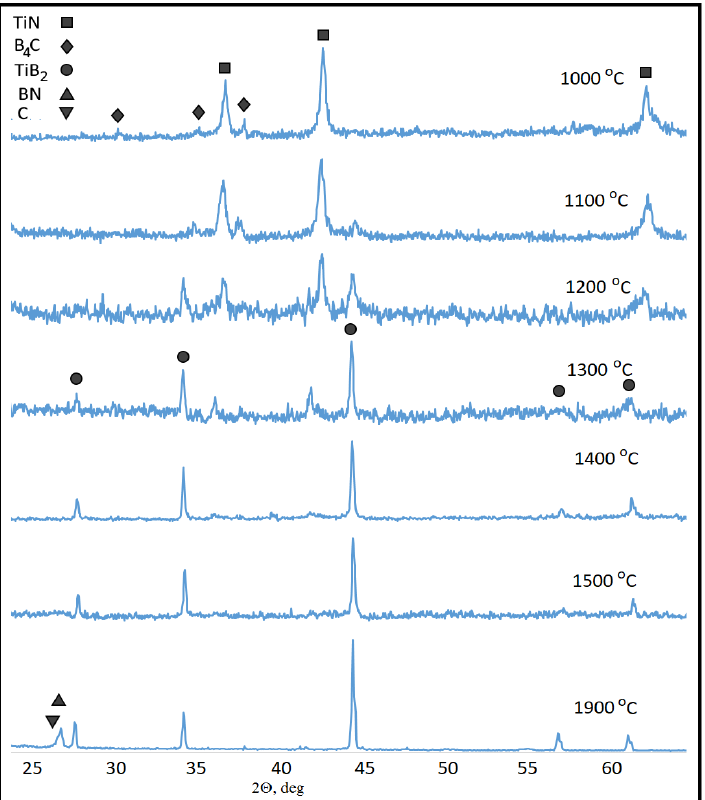
Figure 1. Normalized XRD spectra of 4TiN + 3B 4 C green body after 4-min hot pressing at different temperatures. Peak identification is completed using by Rietveld method.